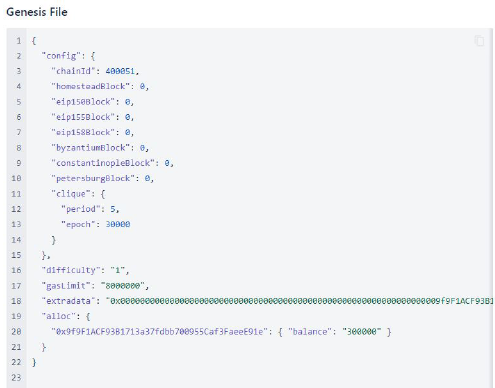
Figure 11. Genesis file.